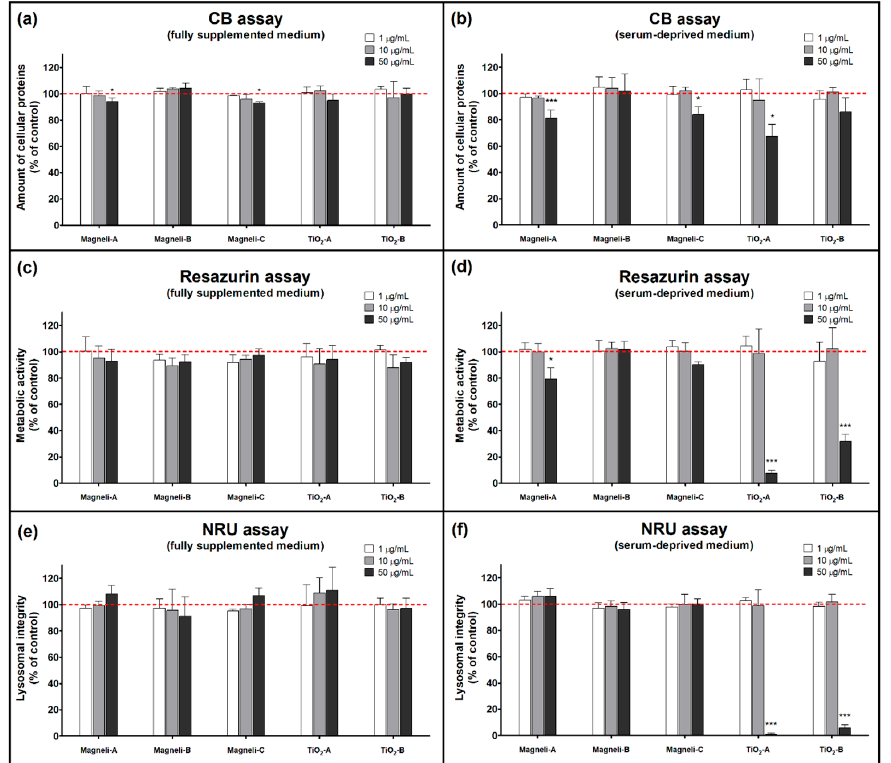
Figure 2. Cytotoxicity of Magnéli phase TiO x and TiO 2 nanoparticles. Cytotoxicity was assessed after 24 h exposure to A549 cells, evaluated by ( a , b ) Coomassie Blue (CB) assay, ( c , d ) Resazurin assay, and ( e , f ) neutral red uptake (NRU) assay. For each treatment condition, at least three independent experimental repeats, each with five replicates, were performed. Data is presented as mean percentage (+SD) of untreated controls (dashed line). Asterisk presents significant difference with respect to the untreated control cells (* equals p < 0.05; *** equals p < 0.001; ANOVA with Bonferroni’s post test).